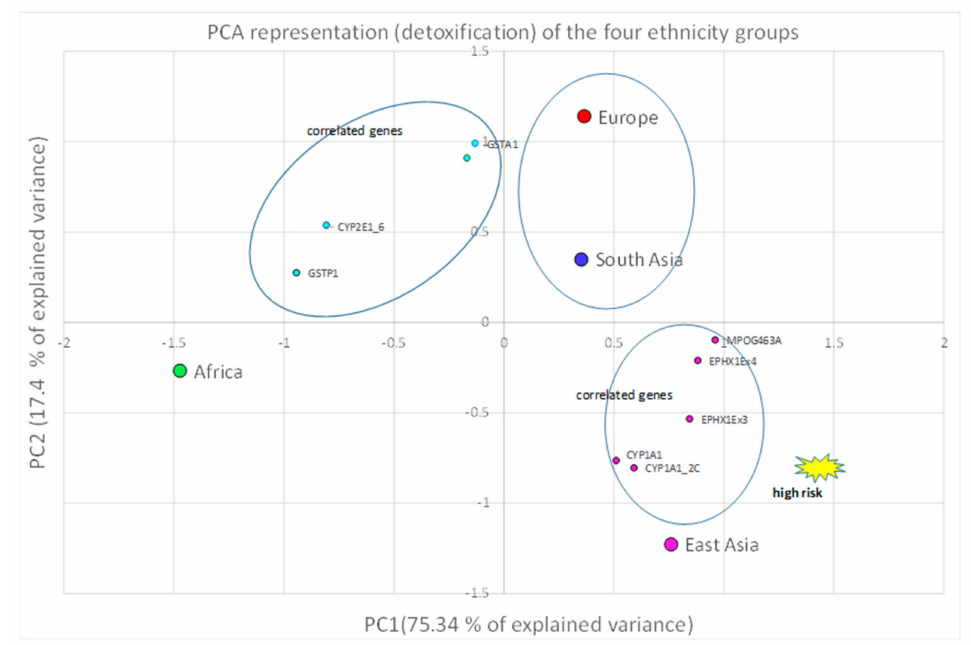
Figure 6. Europe and South Asia show a low-risk similarity in their detoxification genes, while East Asia is associated with a high risk for this gene group.